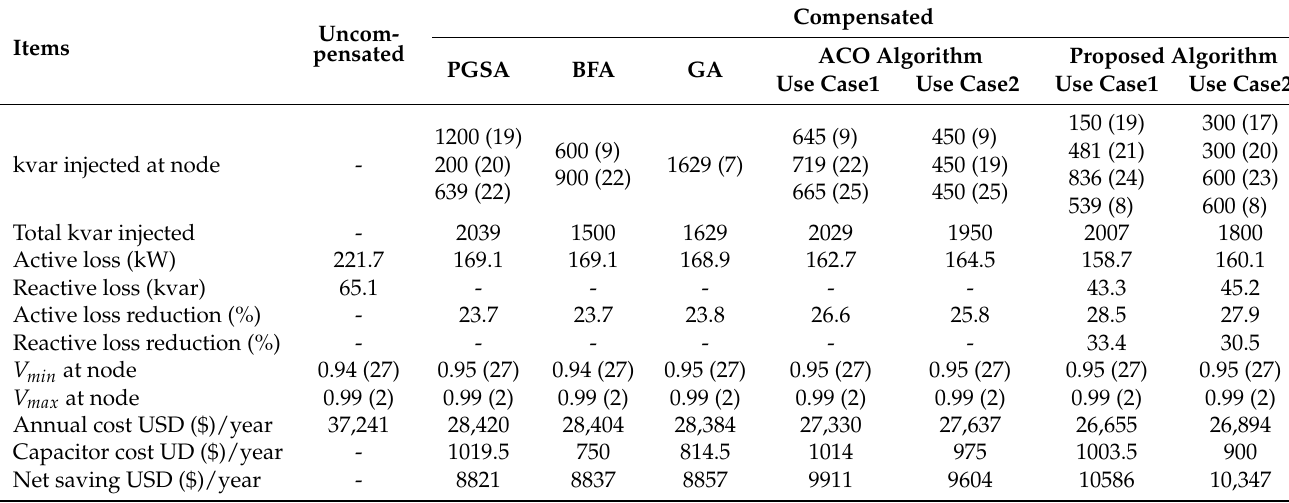
Table 2. Results comparison of N 1 for CS 1